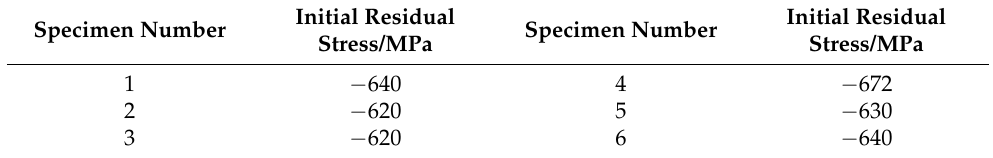
Table 1. The initial residual stress of specimens. Specimen Number